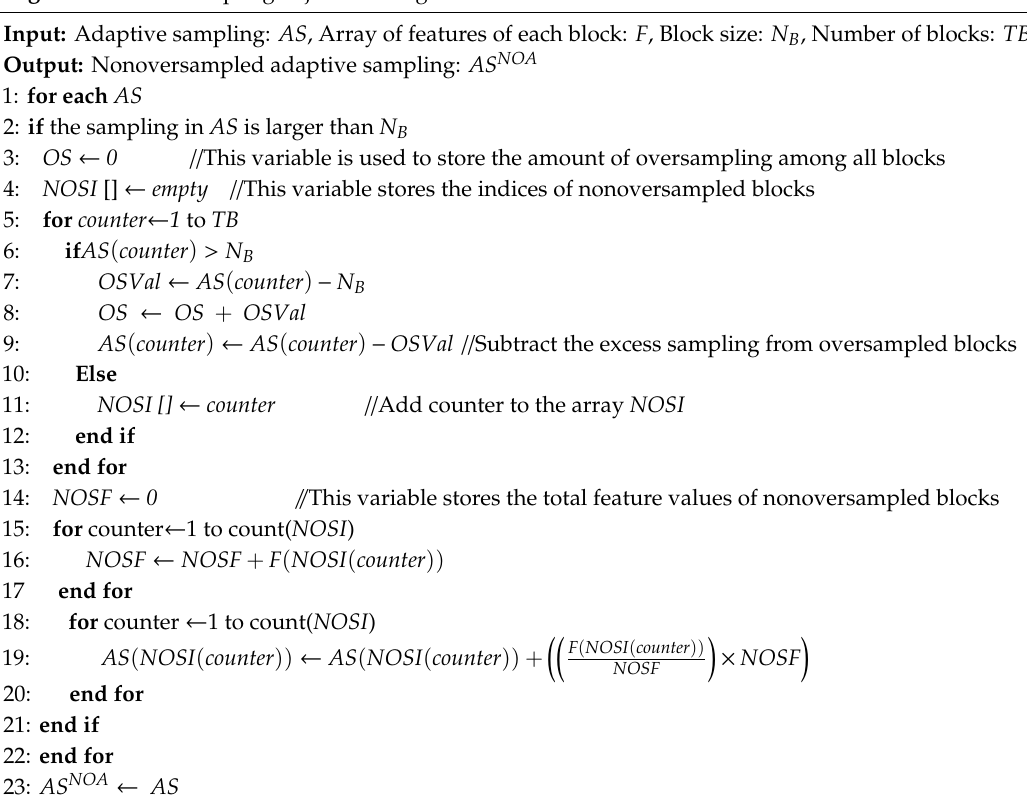
Algorithm 1 Oversampling adjustment